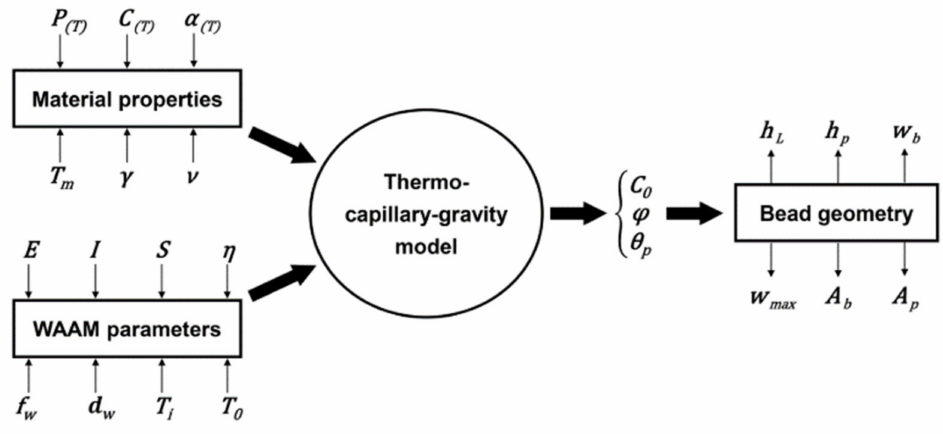
Figure 33. Input and output flowchart of the thermo-capillary-gravity model by Mohebbi